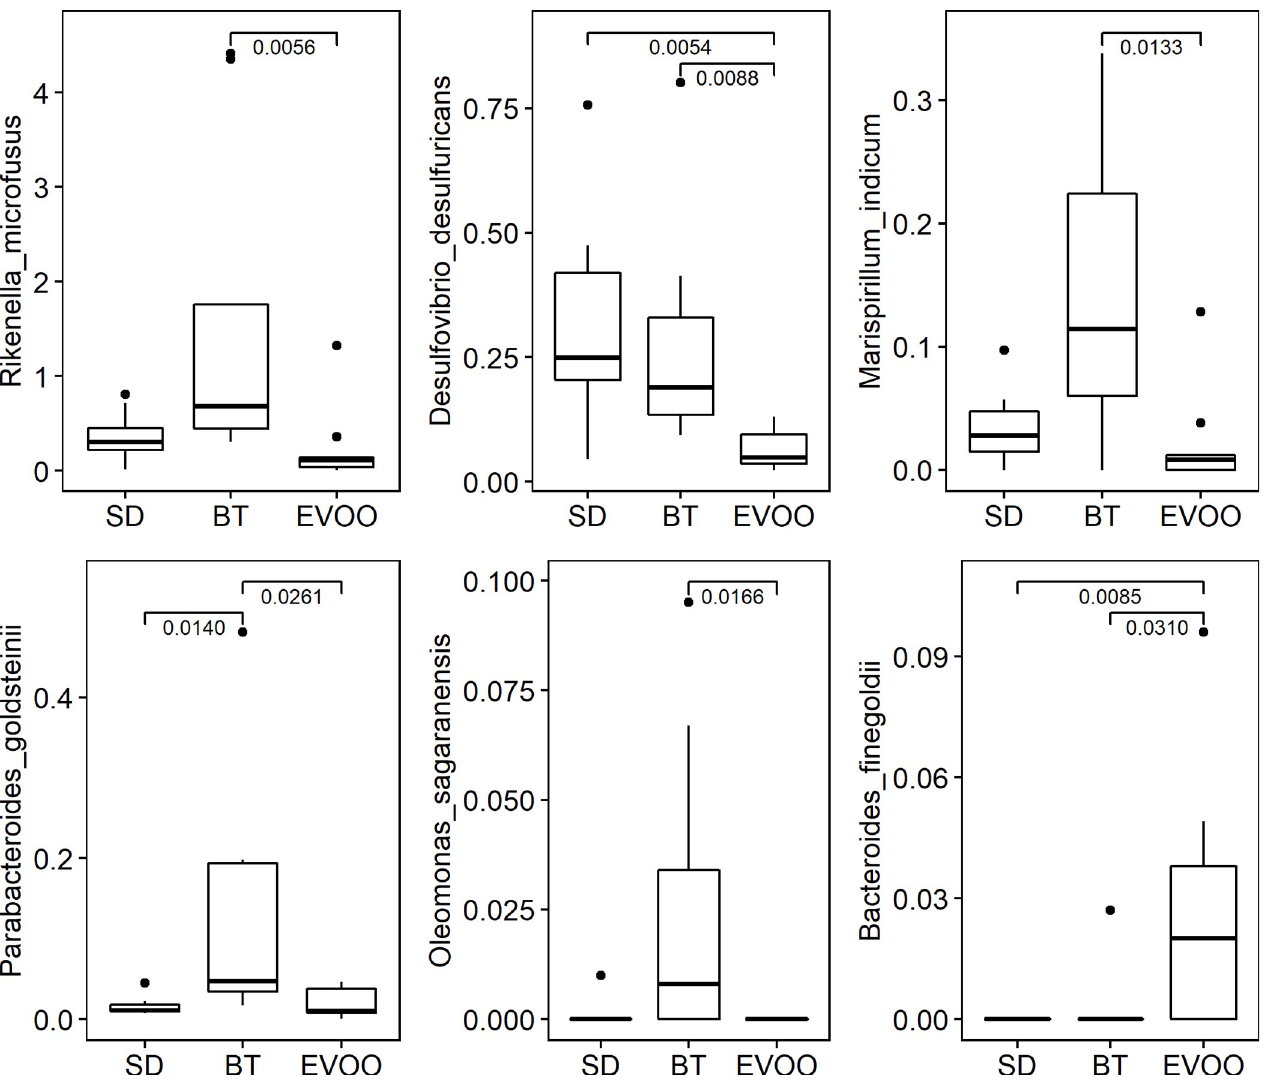
Fig 5. Box-plot representation of the percentage distribution of the six species with significant differences (p < 0.05) between mice fed a diet enriched with butter (BT) and a diet enriched in virgin olive oil (EVOO). SD, standard chow.